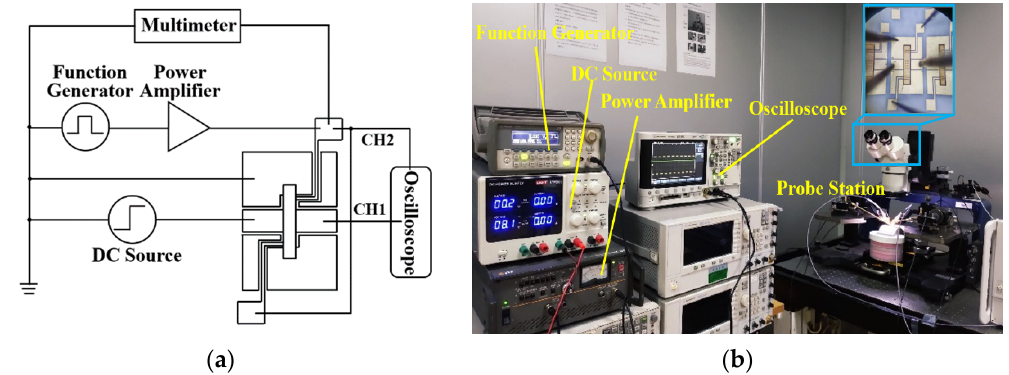
Figure 10. ( a ) Test circuit diagram for the driving time. ( b ) Test platform for the driving time.